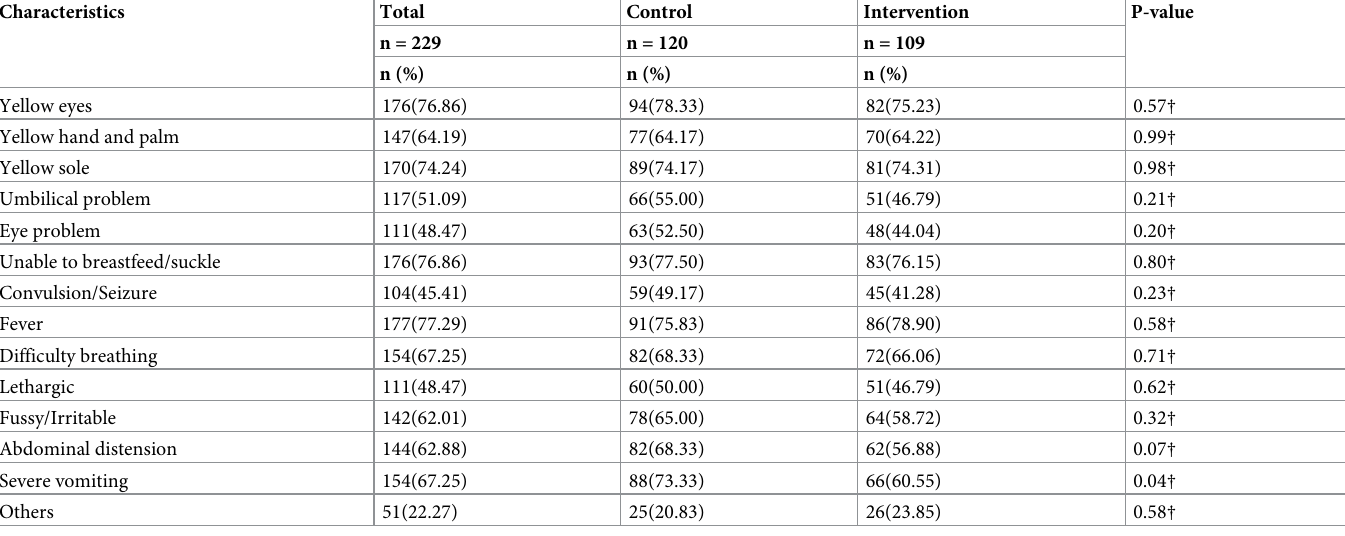
Table 7. Newborn’s danger signs knowledge between intervention and control group at baseline, n =